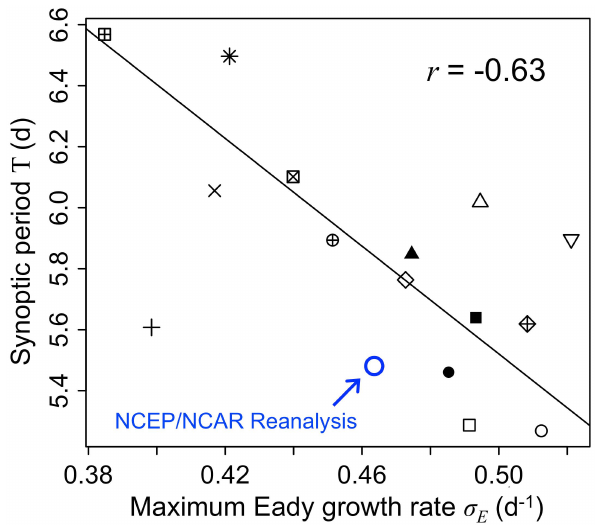
Fig. 5. Relationship between atmospheric baroclinicity and synoptic period T of the dominant meteorological mode for PM 2 . 5 variabil- ity in the Chicago grid cell as simulated by 15 IPCC AR4 GCMs for 1981–2000. The observed value from the NCEP/NCAR Reanal- ysis 1 is also indicated. Baroclinicity is measured as the maximum Eady growth rate σ E for 44–48 ◦ N and 850–500hPa. Each symbol represents an individual GCM (see Fig. 4). Correlation coefficient and reduced-major-axis regression slope are also